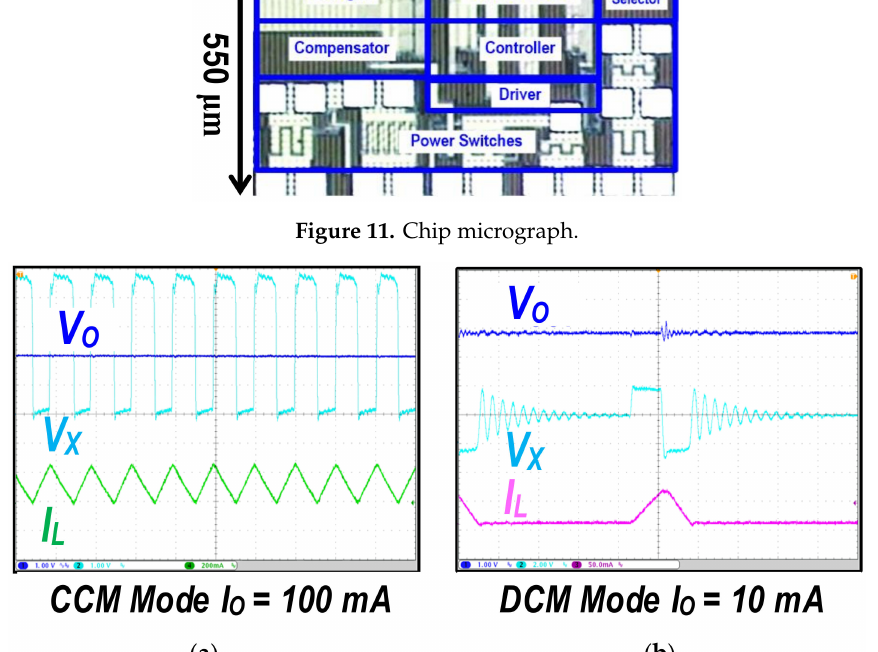
Figure 12. Measurement of steady-state waveforms in the SI converter with ( a ) CCM and ( b ) DCM for V DD = 3.7 V and V O = 1.8 V.